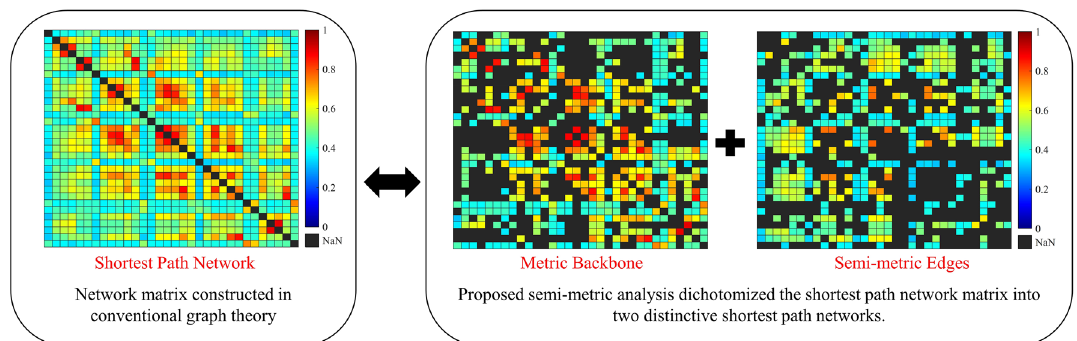
Figure 4. FC maps showing the network matrices involved in conventional graph theory and semi-metric analysis. Further interpretation is conducted in semi-metric analysis where the information about sharing feature in a shortest path matrix is considered.